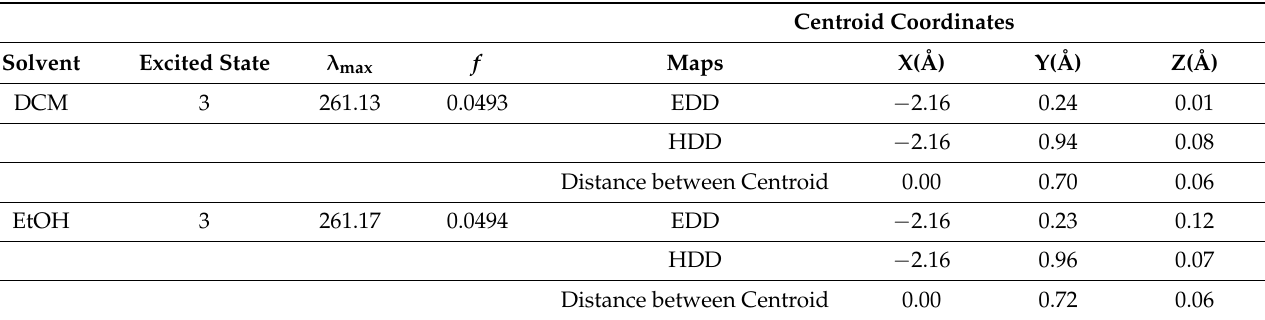
Table 7. Calculated EDD and HDD centroid coordinates and distances for 21HBMBA allowed excited state transitions in DMSO and